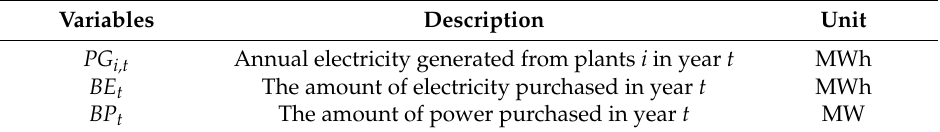
Table 3. List of